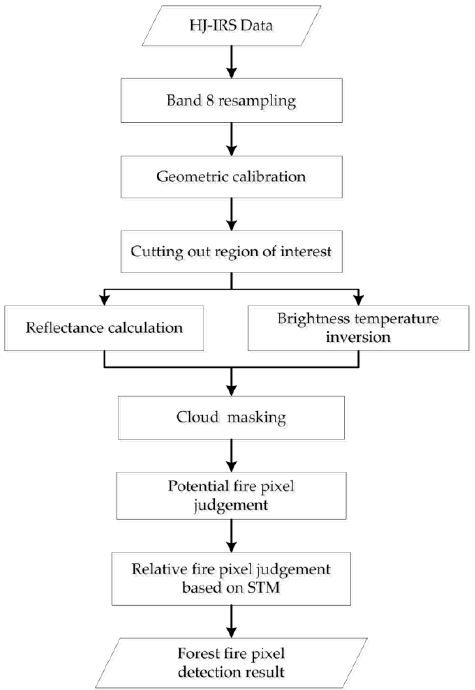
Figure 6. Workflow of the spatio-temporal model (STM) based forest fire detection method.